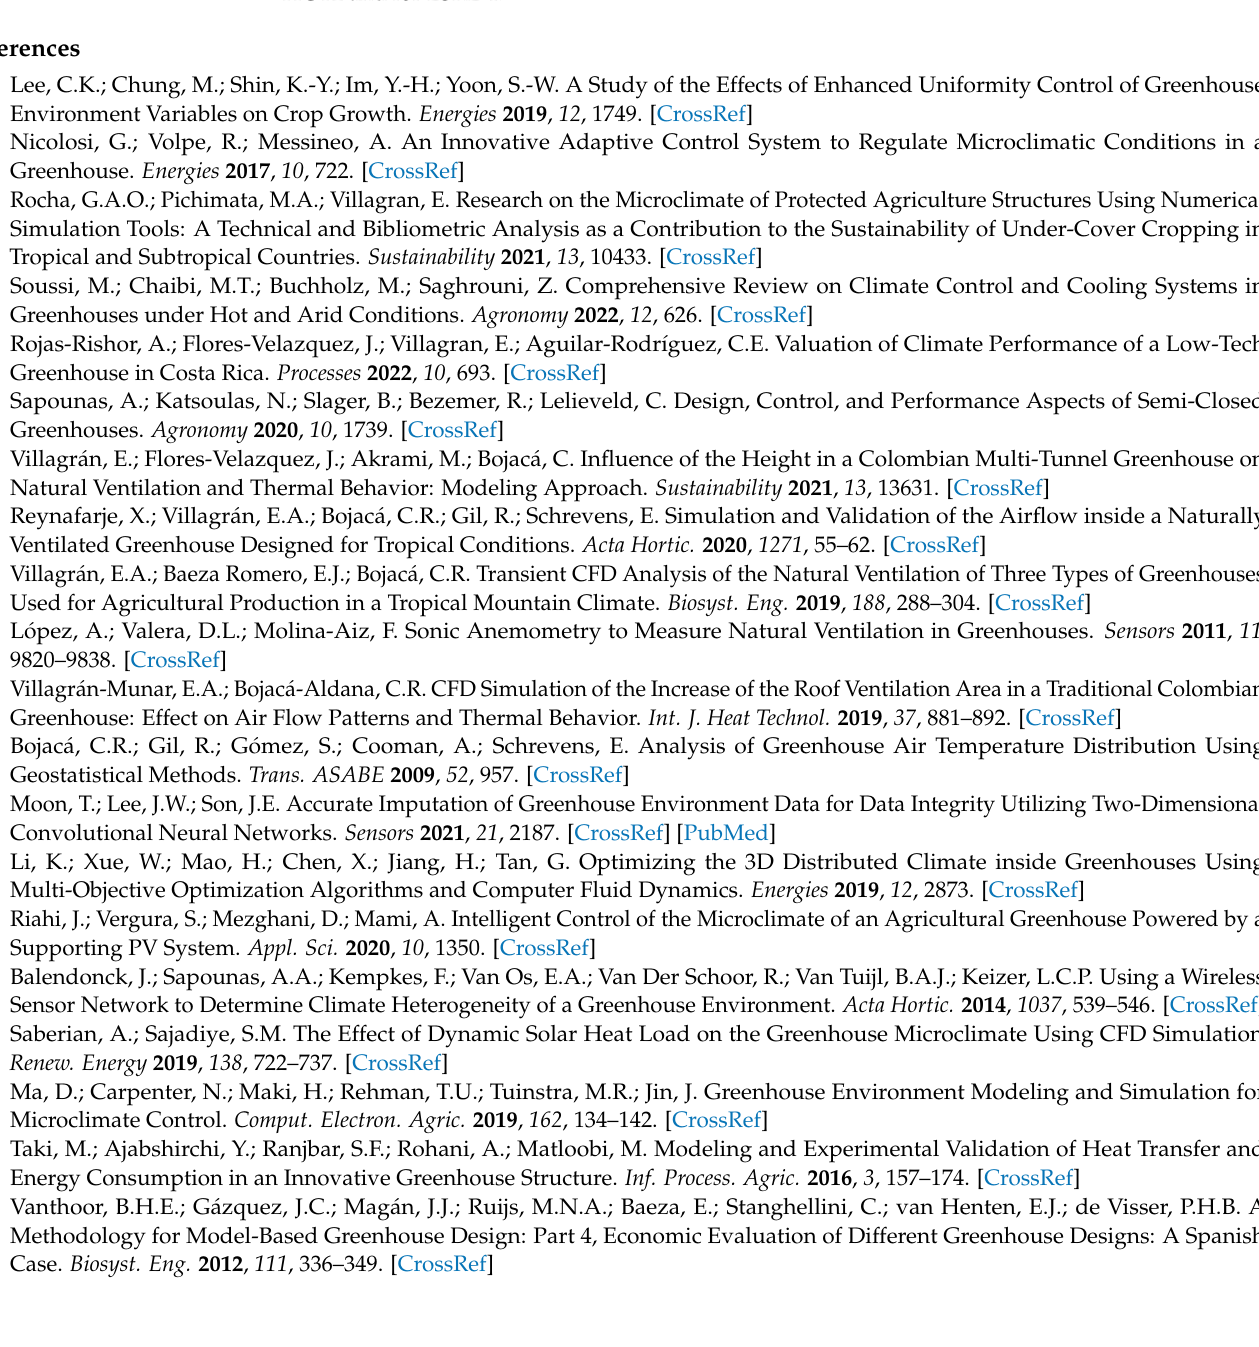
Figure A15. Spatial distribution predicted by kriging, for temperature, relative humidity and VPD in HGT2 and for ESRL 4.